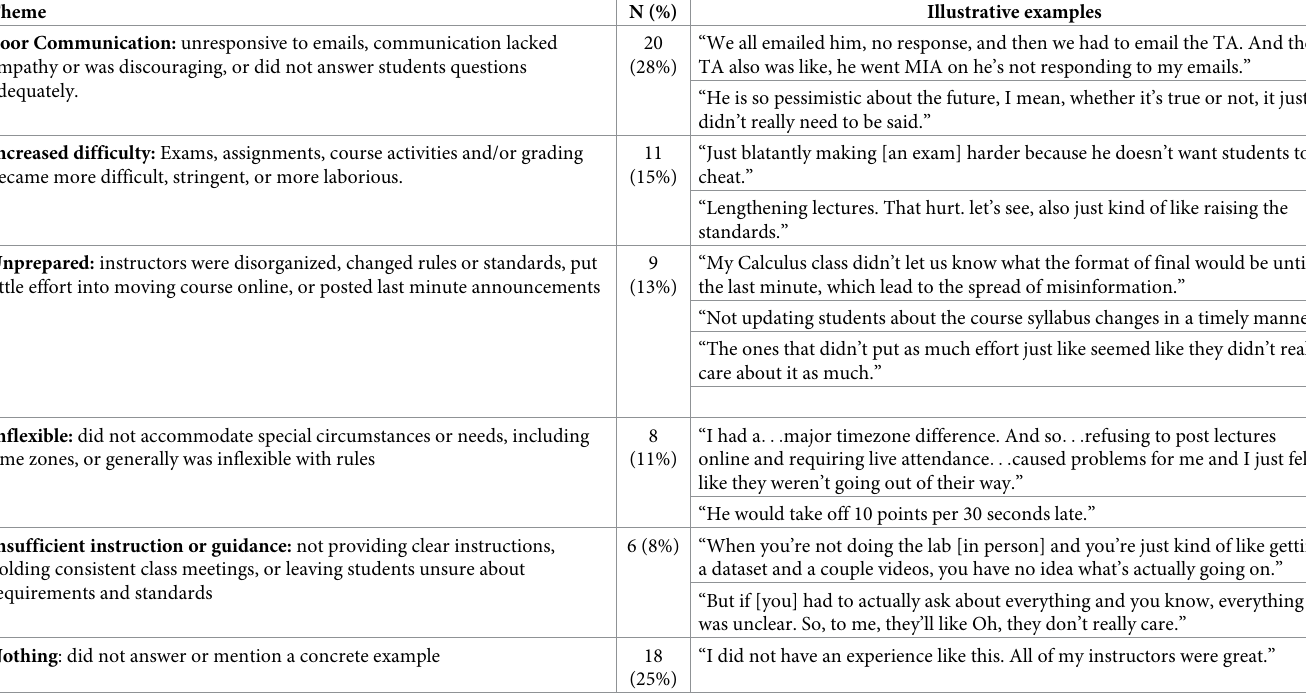
Table 6. Actions that made students feel their instructor doesn’t care (N = 59 participants, N = 72 responses). Theme N (%) Illustrative